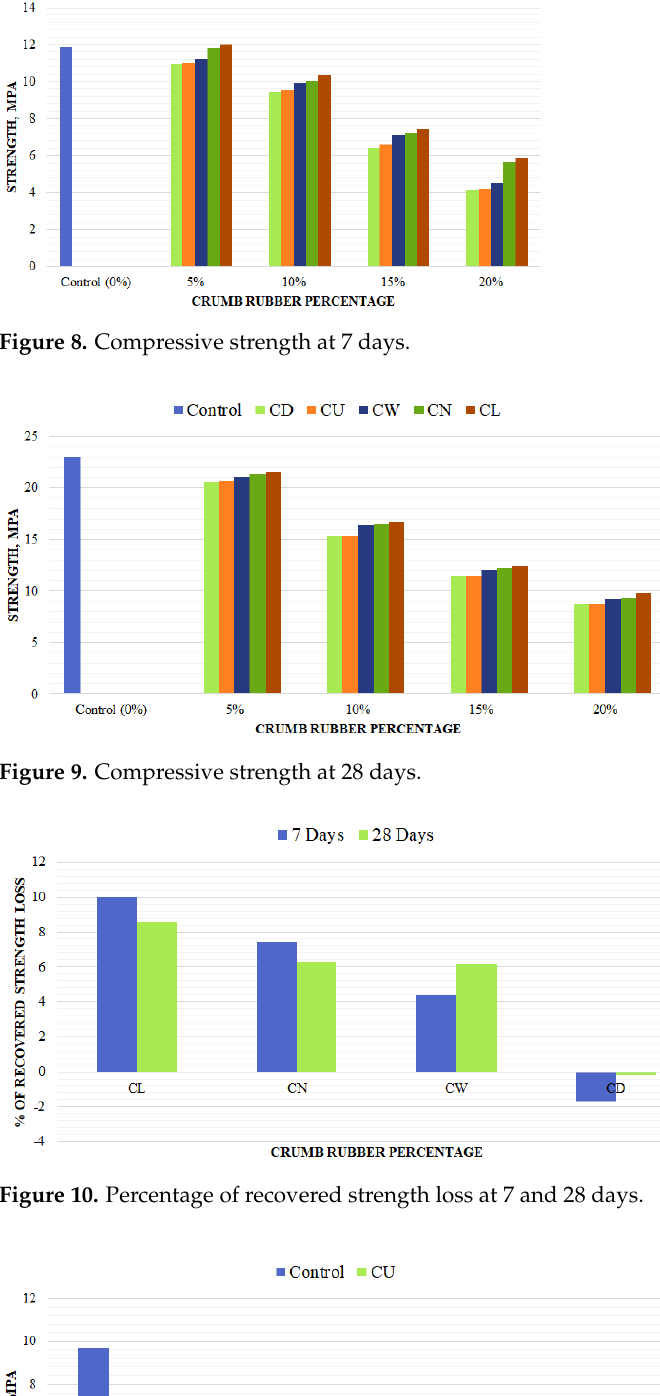
Figure 11. Compressive strength (after heating) at 28 days . 3.7. Indirect Tensile Strength Indirect tensile strength was found to be following the same pattern of compressive strength. At 28 days of curing there was a loss of 3.56% in indirect tensile strength at 5% replacement, 24.25% loss at 10% replacement, 50.68% loss at 15% replacement, and 84.25% loss of indirect tensile strength at 20% replacement level of sand with CR (Figure 12). Ba- tayneh et al. [8], also found that with the increase in CR, there is a loss in tensile strength of concrete. Lime treatment managed to recover 9.16% of strength loss, NaOH treatment recovered 6.14% of strength loss, and water treatment recovered 1.37% of strength loss. Detergent as in all cases reduced the tensile strength to a further 1.03%. The reduction in indirect tensile strength might be due to the weak bonding between CR and cement. The ITZ acted as a micro-crack between the two materials. This weak ITZ accelerated the re- duction in tensile strength [60].